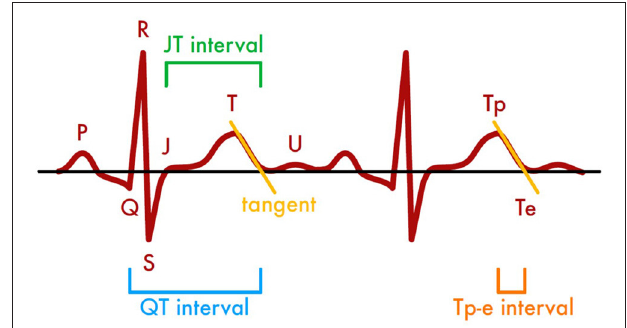
FIGURE 1 | Methods of assessing time intervals in ECG recordings based on the tangent method.